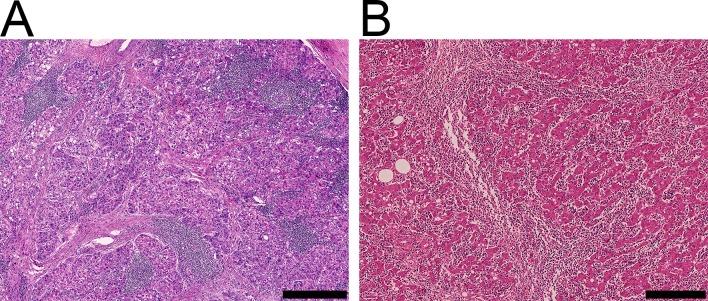
Hepatocellular carcinoma with lymphoplasmacytic infiltration.(A) Multifocal infiltration pattern. Scale bar represents 500 μm. (B) Diffuse infiltration pattern throughout the tumor, corresponding to lymphoepithelioma-like carcinoma. Scale bar represents 200 μm.